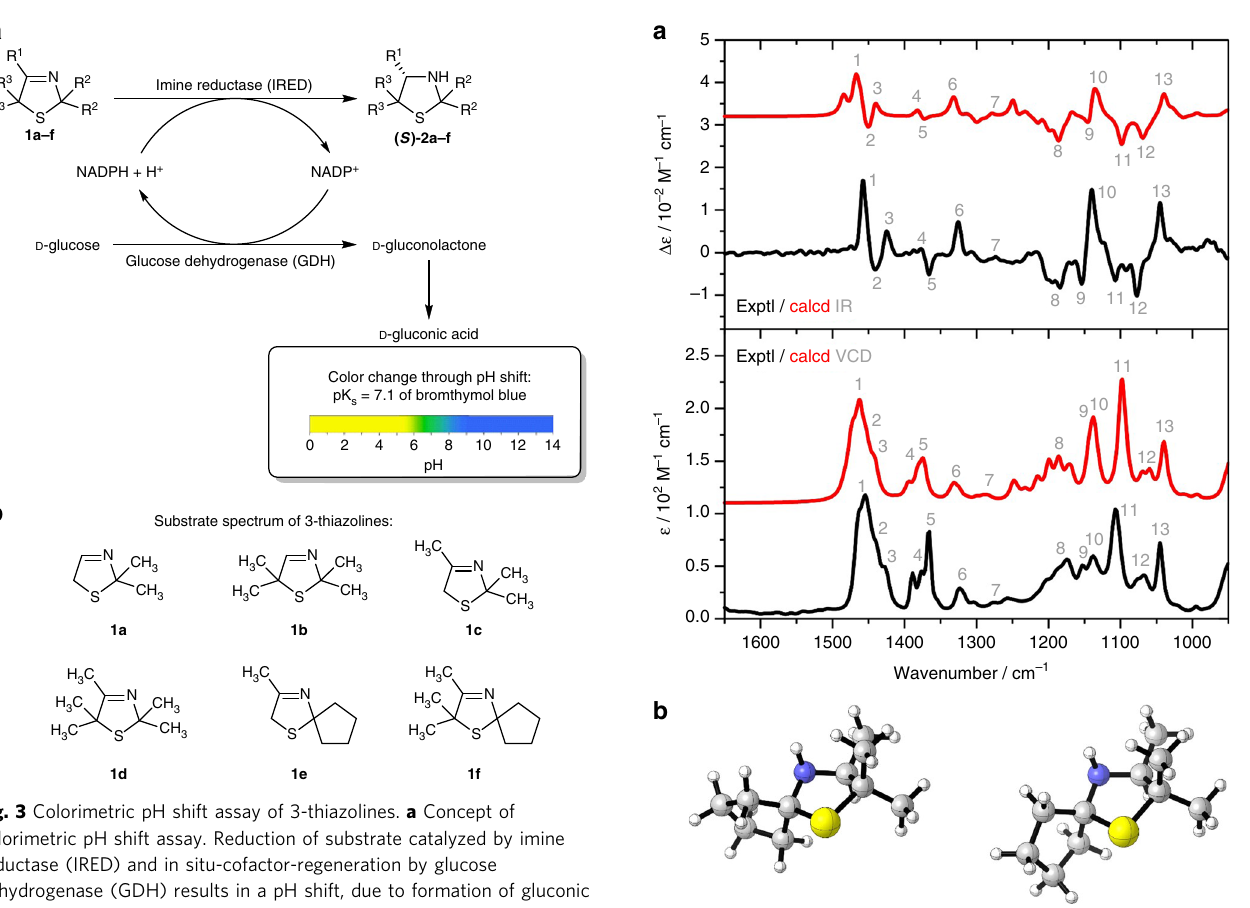
relative Gibbs free energies Δ G 298K and the corresponding Boltzmann weights of the two populated conformers are shown in Fig. 4b. Based on the single-conformer spectra, the IR and VCD spectra were simulated by assigning a Lorentzian band shape to the dipole and rotational strength calculated for each conformer and subsequent Boltzmann-averaging of the spectra. Direct comparison of the resulting simulated IR and VCD spectra with the experimental data, as indicated by the assignments given in Fig. 4a, reveals a very good agreement. Therefore, the absolute con fi guration can be assigned with very high con fi dence as ( S )- 2f .